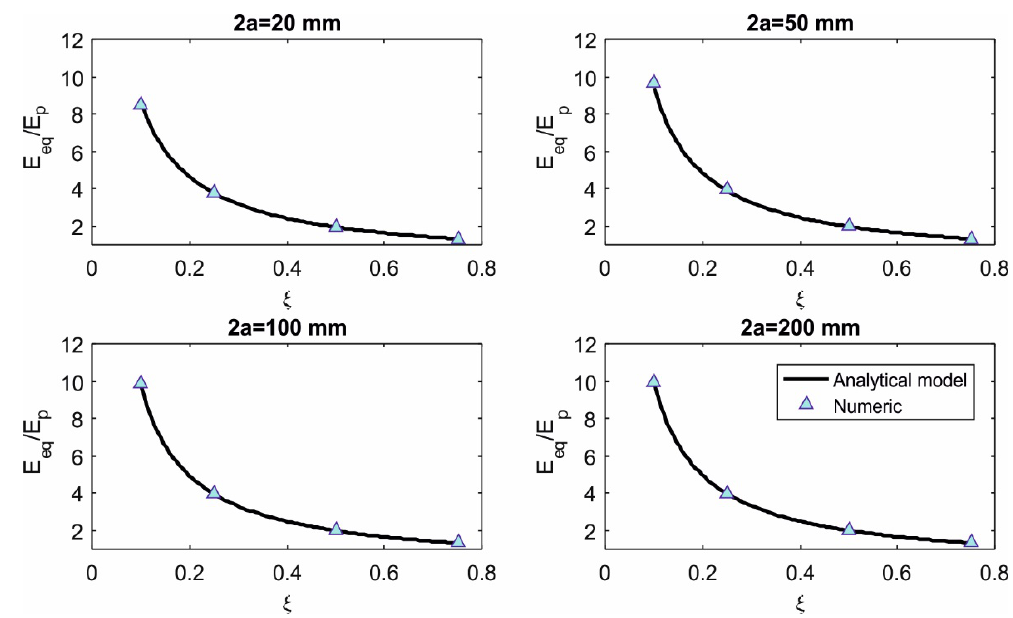
Fig. 6 Ratio E eq / E p , as a function of the percentage of detached interlayer ξ = λ / a , for different values of the fragment length 2 a and for interlayer thickness of 1.52 mm. Comparison between analytical and numerical